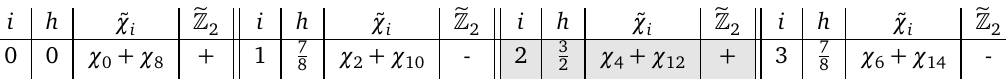
/ (cid:90) Table 25: SU ( 16 ) : primaries labeled by i are characterized by weights h . Their characters 1 2 ( τ ) are expressed in terms of the characters χ ˜ χ of the SU ( 16 ) WZW model (see table 24). We i i 1 highlight the primary related to the (cid:101) (cid:90) 2